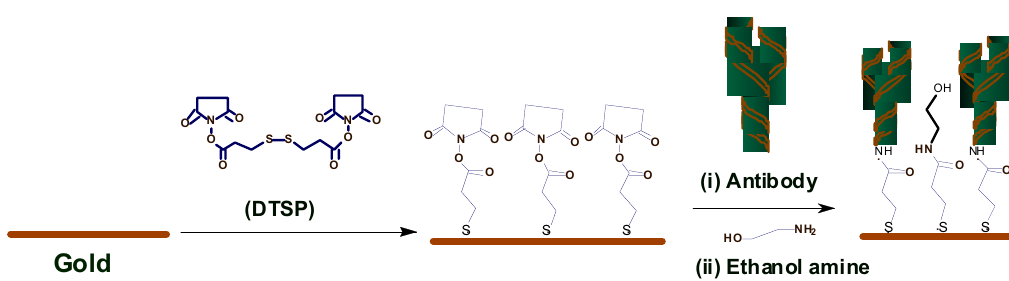
Figure 1: Schematic of EA/C-Mab/DTSP/Au bio-electrode fabrication. Figure 4. Ethyleneamine (EA)/C-Mab/dithiobis succinimidylpropionte (DTSP)/Au bio-electrode [23].